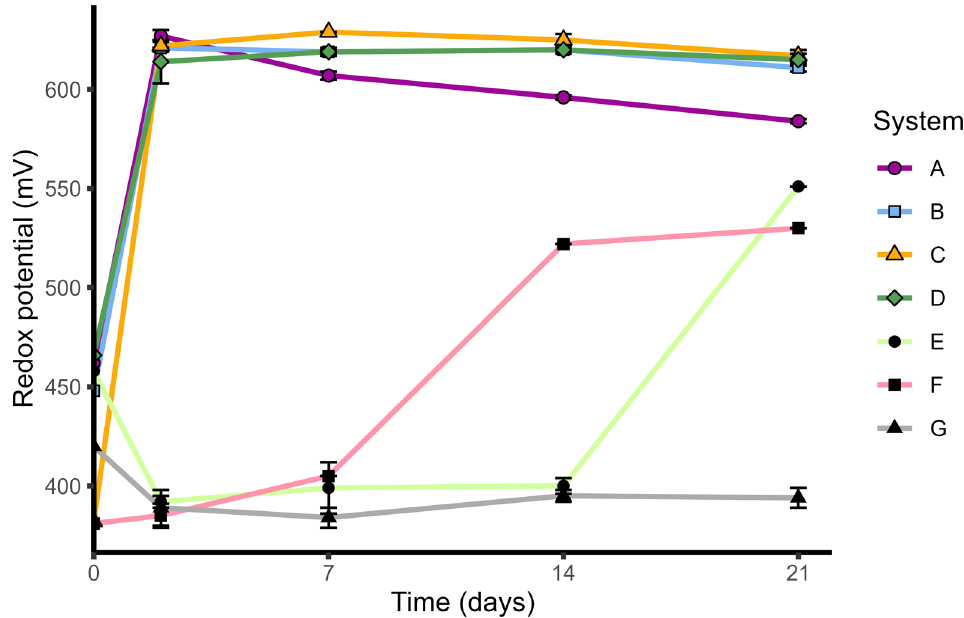
Figure 4. Evolution of ORP values during bioleaching tests at 30 °C with native consortium. Inocu- lated systems were performed in ( A ) distilled water, ( B ) MAC medium, ( C ) MAC medium + Fe(II) + S(0), ( D ) local groundwater with initial pH adjusted to 2.0. Non-inoculated controls were per- formed in MAC medium ( E ), MAC medium with Fe(II) and S(0) supplementation ( F ), and using a sterilized mineral with the addition of paraformaldehyde ( G